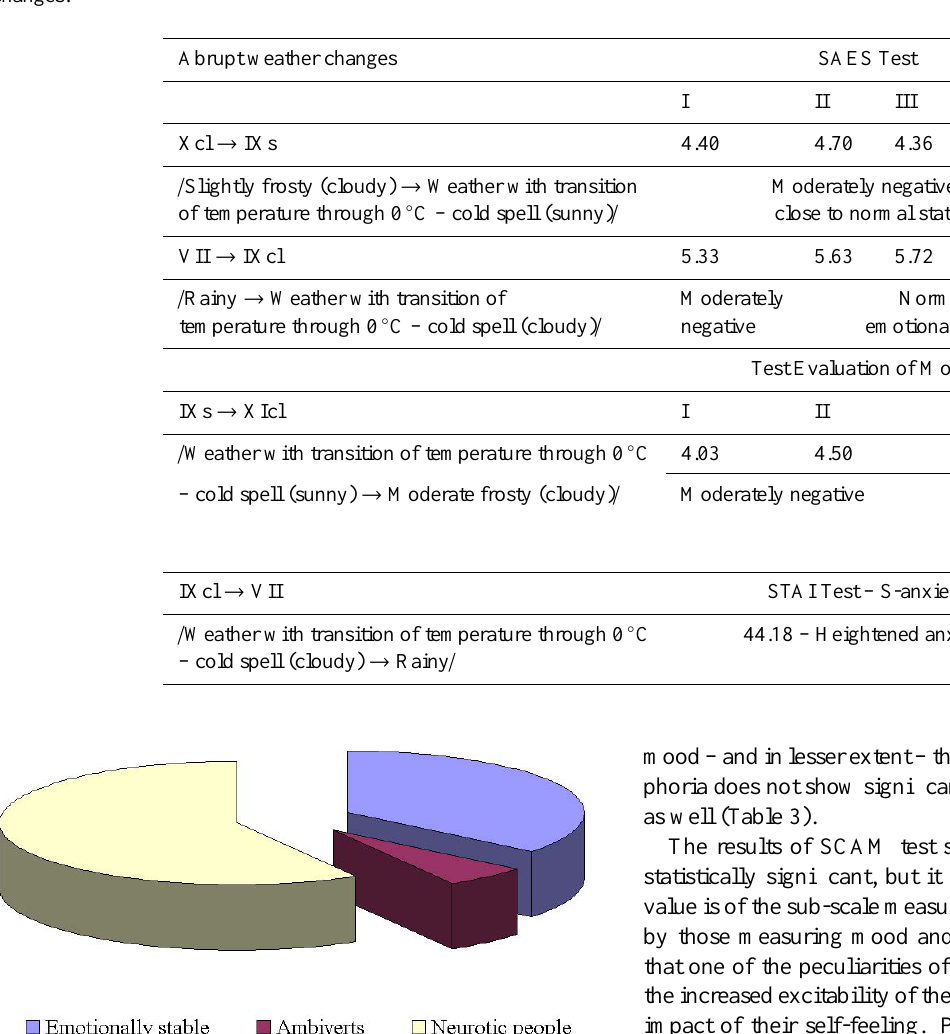
Table 2. Qualitative assessment of the emotions of the volunteers by mean average values in di ff erent sub-scales during abrupt weather changes.